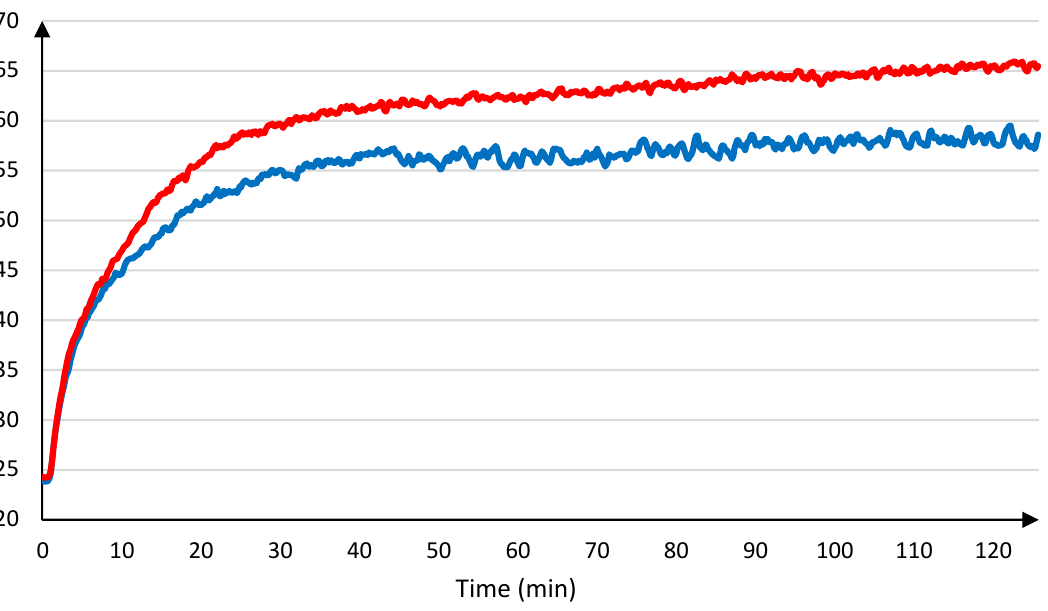
Figure 5. Trend of the simulated radiation for the reference case (blue line) and the enhanced panel (red line). The comparison of the temperatures between the reference case and the enhanced PV panel is shown in Figure 6. The front temperature of the pure panel is depicted with the red line, while the blue line indicates the front temperature of the graphene/fins/PCM PV system.